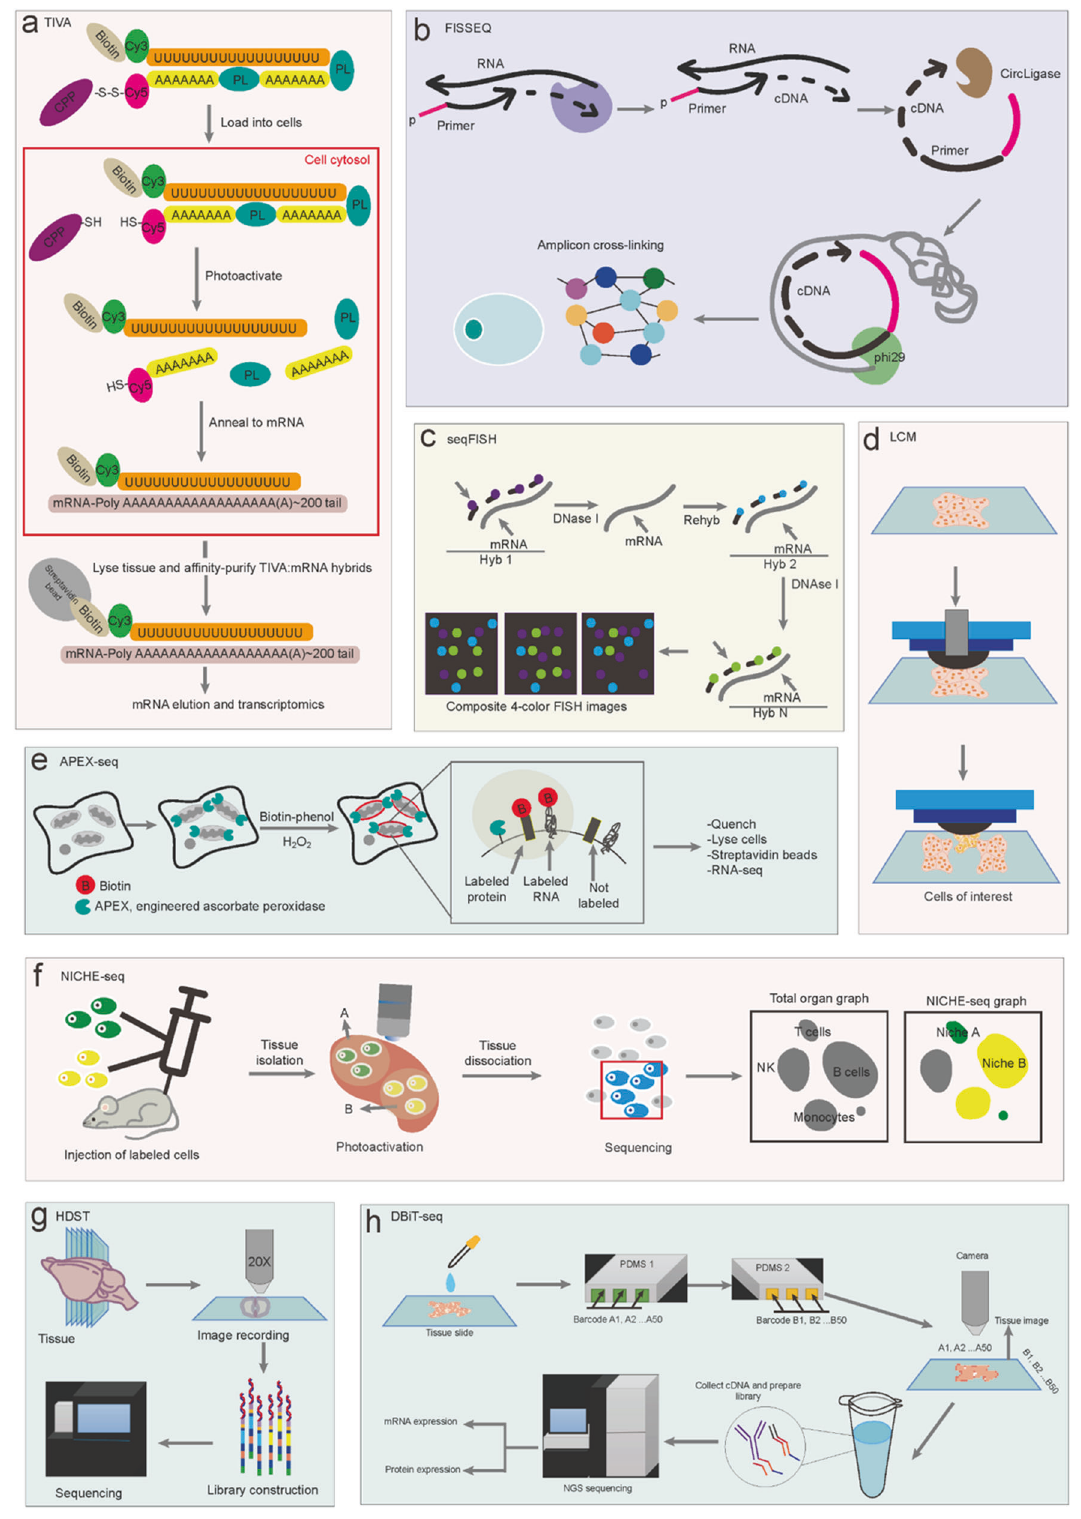
Fig. 2 Technical procedures of spatial transcriptomic measurements based on various principles. a Procedures from cell loading, photoactivation, mRNA annealing, hybrids, and elution to transcriptomic sequencing TIVA; b Procedures from reverse transcription, cDNA linking, circularizing, rolling circle replication, and amplicon cross-linking to sequencing for FISSEQ; c Procedures from repeated FISH probe hybridization and digestion to FISH imaging for seqFISH; d Procedures from sample coating and selection to capture of target area for LCM; e Procedures from biotin-phenol labeling of proteins and genes to RNA-seq for APEX-seq; f NICHE-seq includes labeled cells injection, tissue isolation, dissociation, and sequencing of photoactivated cells. g Procedures from tissue section, image recording, and library preparation to sequencing for HDST; h Procedures from DNA- antibody conjugating, barcoding, tissue imaging, and library construction to sequencing for DBiT-seq